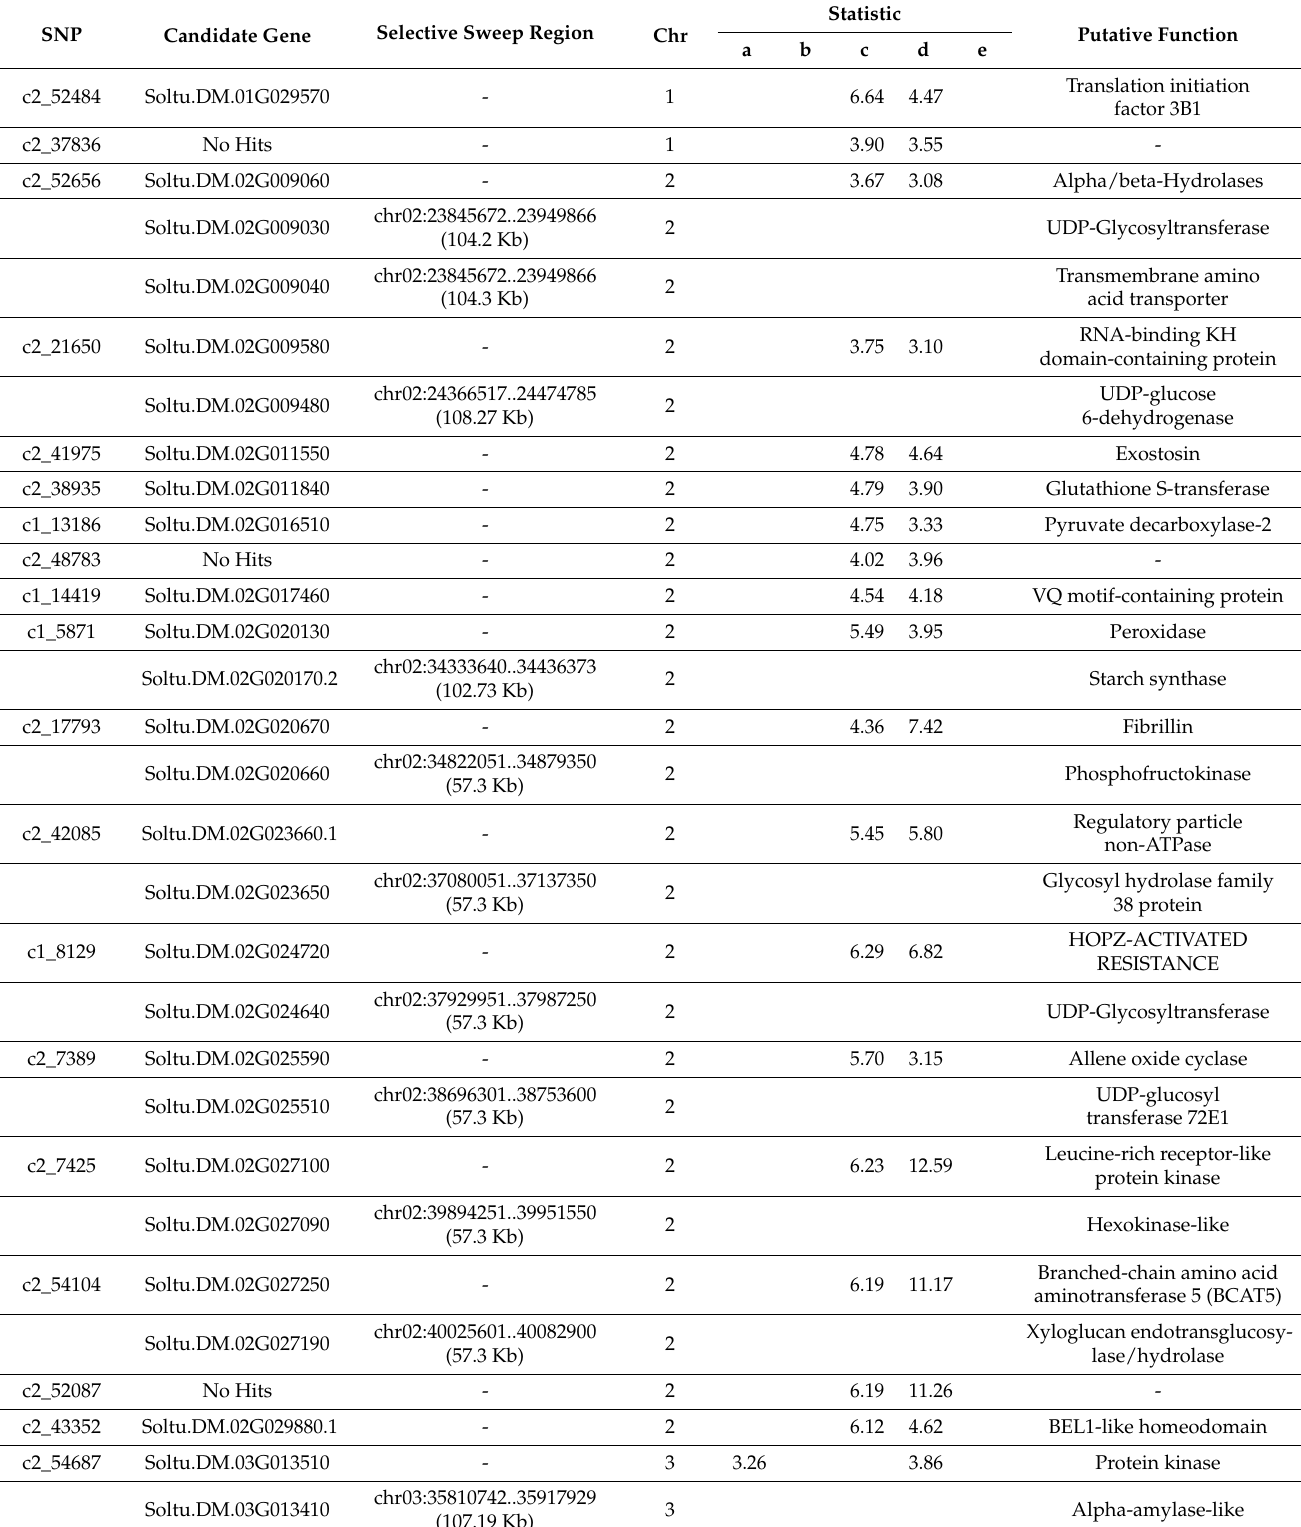
Table 2. Summary of genetic variants detected by more than two approaches among the applied five approaches including GWAS, XP-CLR, PCAdapt, iHS, and